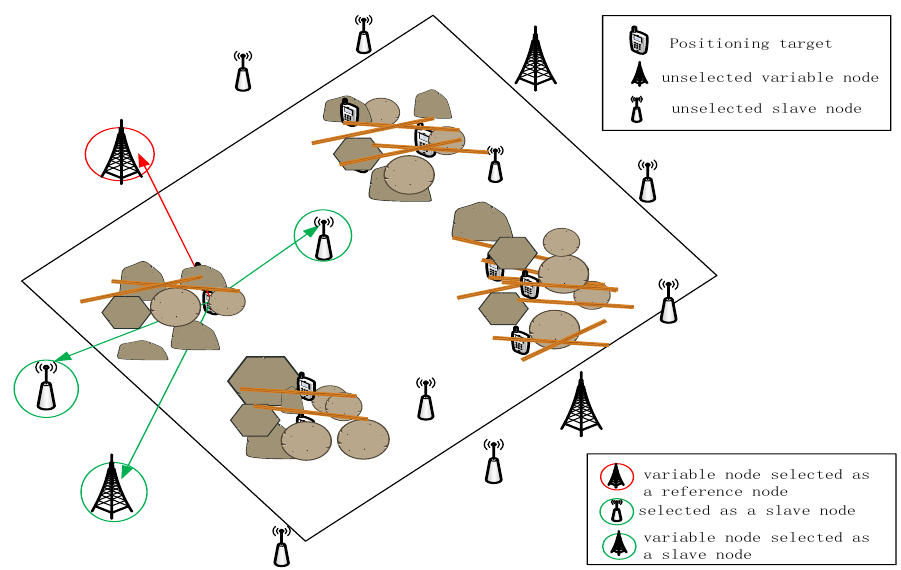
Figure 4. Schematic diagram of detection device selection problem.